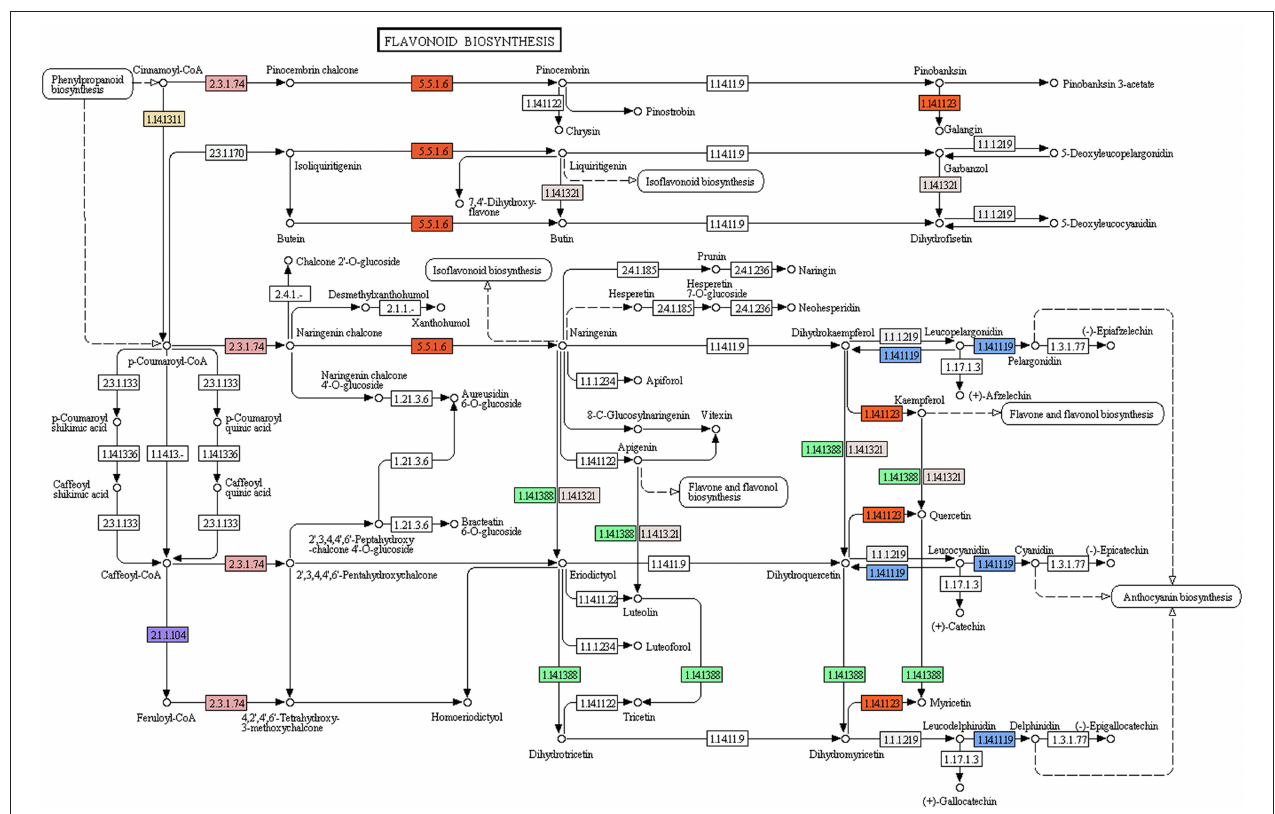
FIGURE 7 | Flavonoid biosynthesis pathway study in P. amarus leaf transcriptome representing each of the identified colored EC.